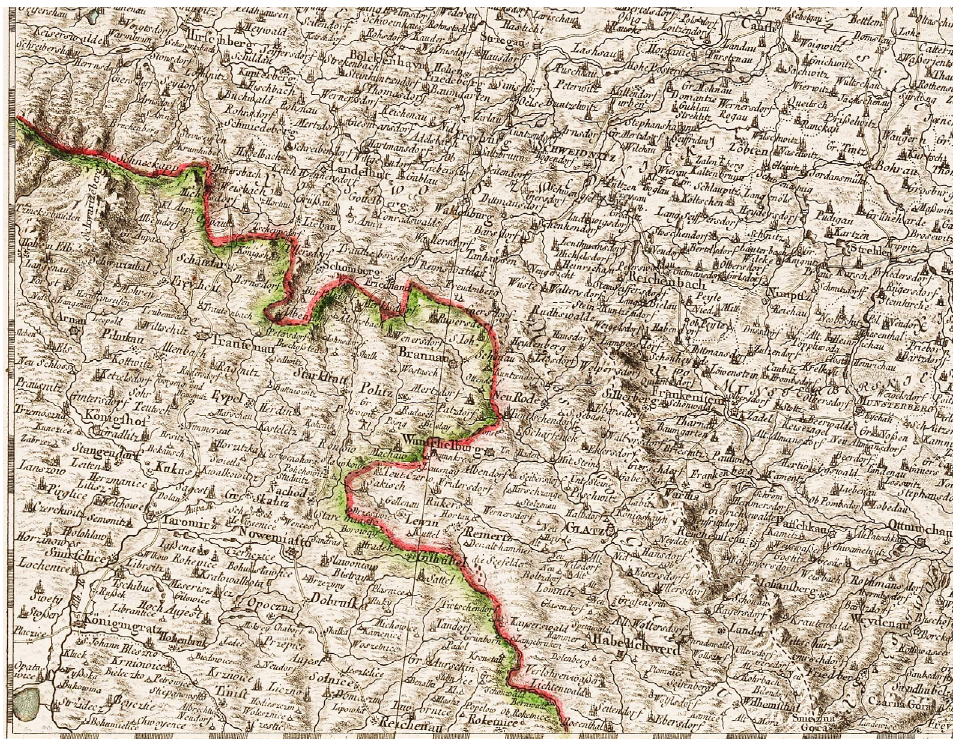
Fig. 7. Part of the Carte de la Pologne by J.A. Jabłonowski and G.A. Rizzi-Zannoni from 1772 presenting Sudetes (source: